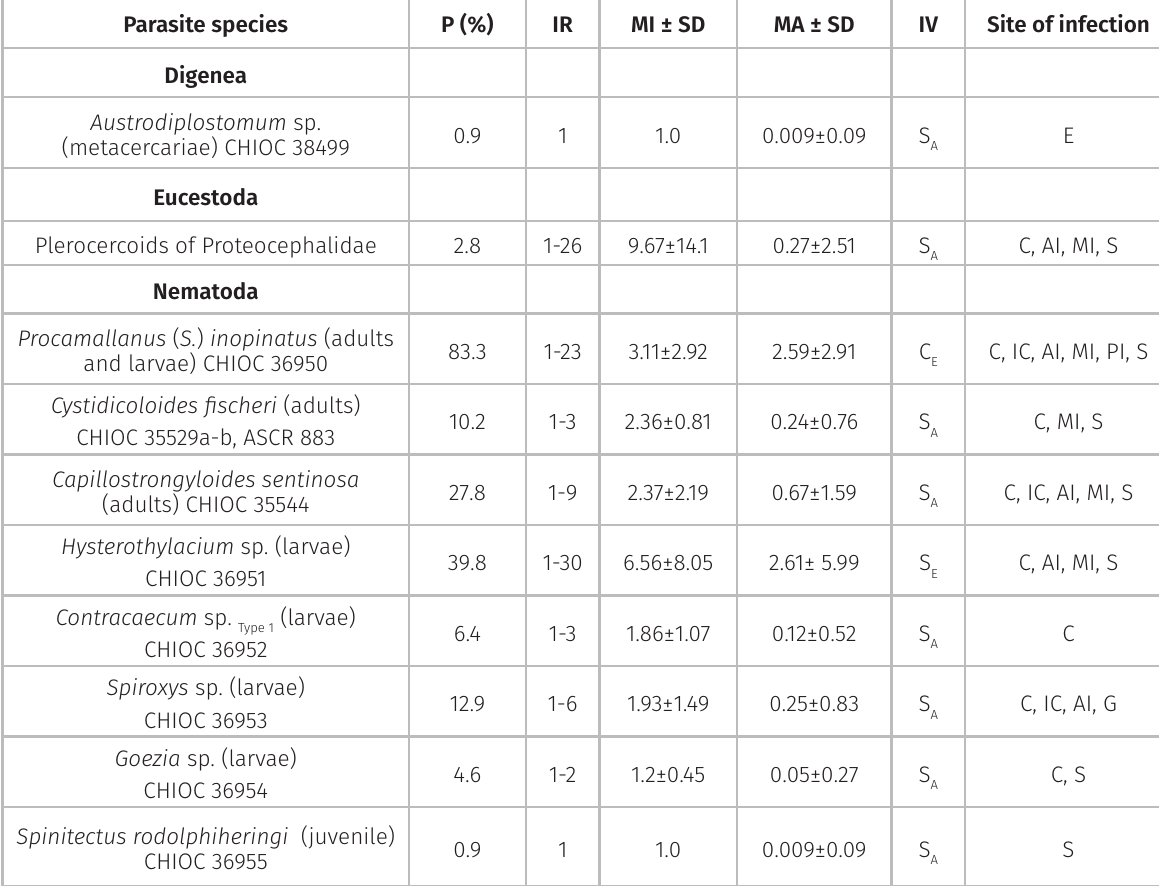
Table I. Prevalence (P), intensity range (IR), mean intensity (MI) and mean abundance (MA) and their respective standard deviation (SD); importance of values (IV) and site of infection of the metazoan endoparasites